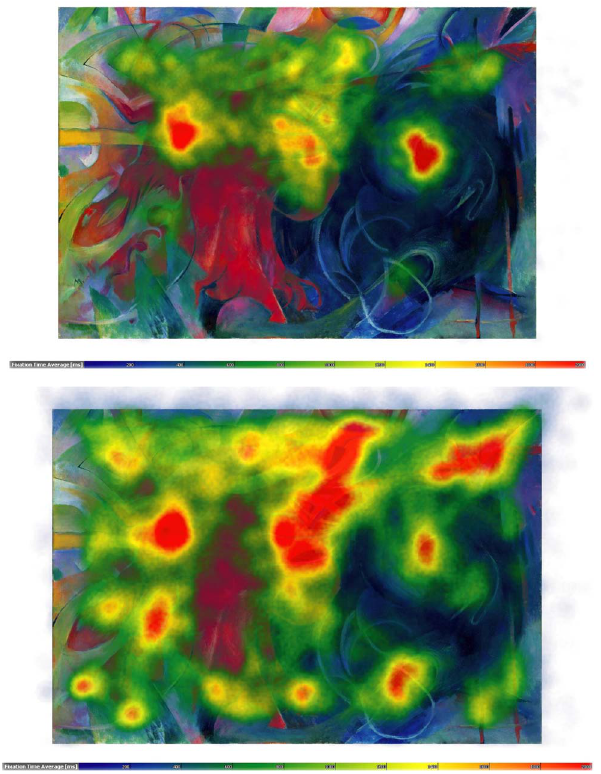
Fig. 4. Speaking effects on fixation dispersion and duration – Marc. Heat map showing the total time certain areas of the painting have been fixated by the experimental group during minute 11 to 15. Areas fixated for more than 2,000 ms/minute are displayed in red. Colour scaling is in 200 ms steps. Heat map visualising the total time certain areas of the painting have been fixated by the control group during minute 11 to 15. Areas fixated for more than 2,000 ms/minute are displayed in red. Colour scaling is in 200 ms